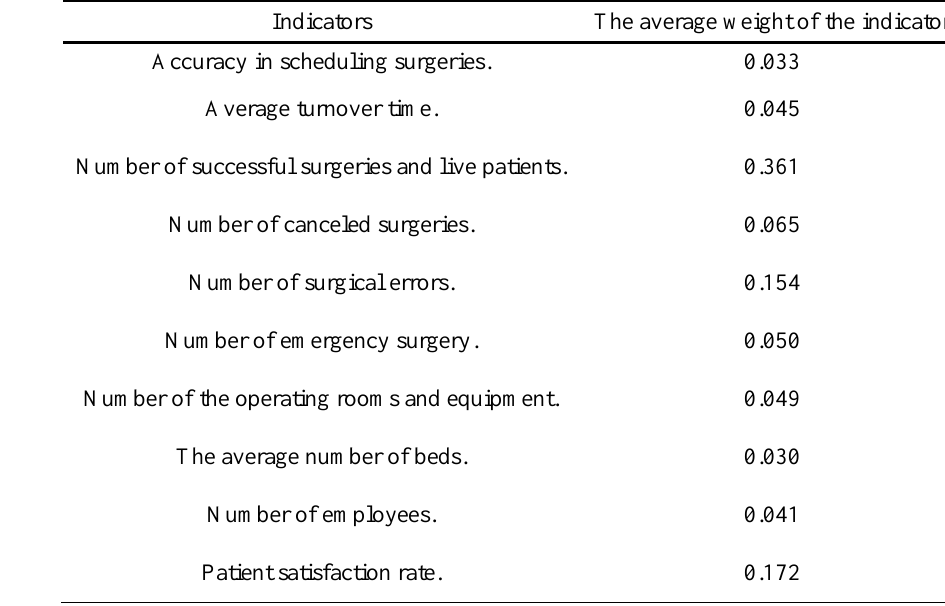
Table 5. The average weight of the